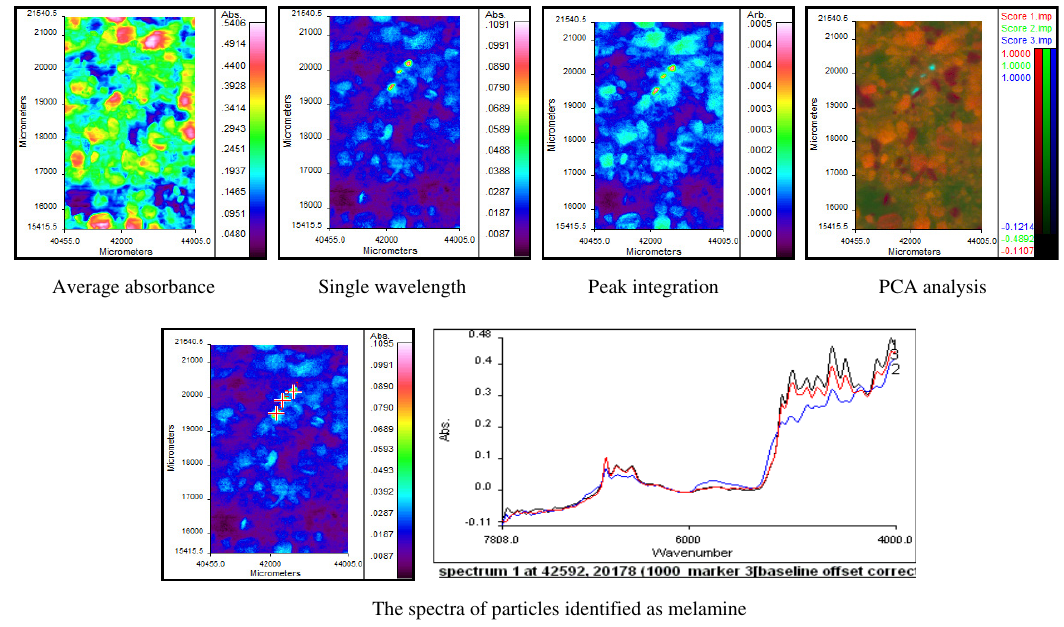
extensively used in NIR image analysis to determine compound distribution. 21 Information from mela- mine can be mainly extracted in 2nd score images. Figure 6 was 2nd score images of sample with di®erent preprocessing. The preprocessing method of second derivative gave the best identifying result for melamine